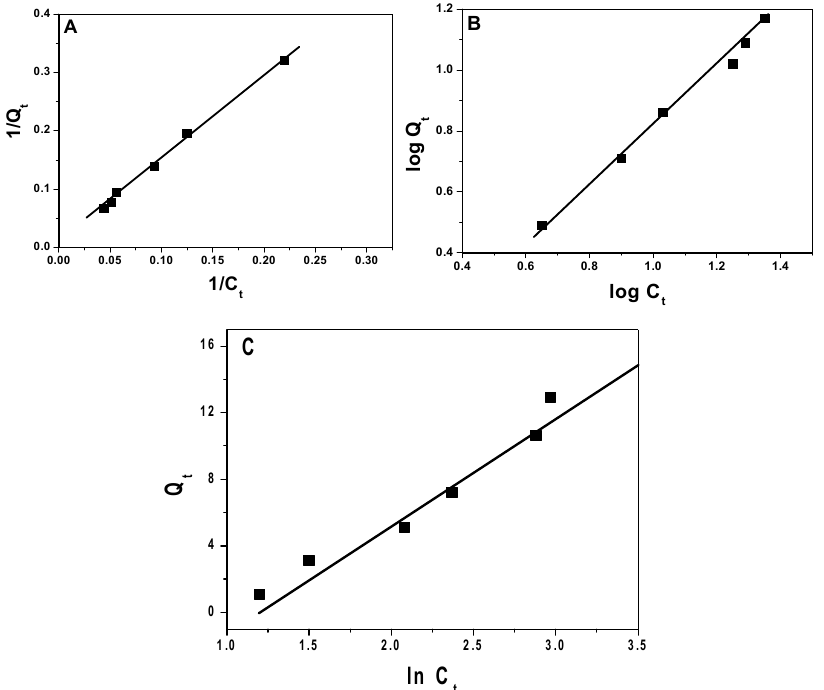
Figure 8. ( A ) Langmuir, ( B ) Freundlich, and ( C ) Temkin isotherms for mercury removal using CuFe 2 O 4 nano-particles (NPs).